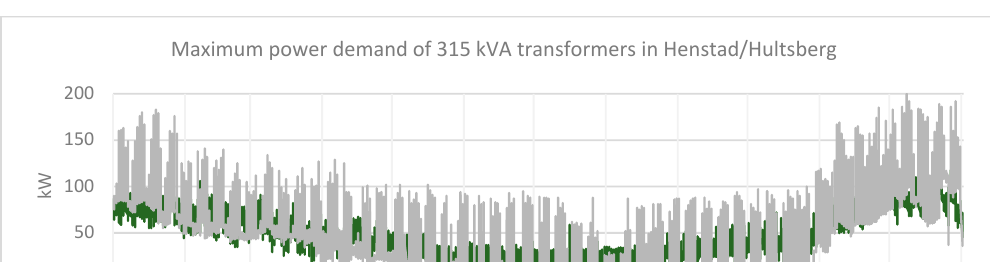
Figure 2. The power demand of 500 kVA transformers.